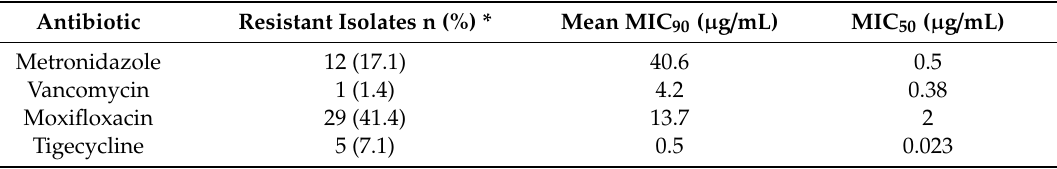
Table 2. Prevalence of all C. di ffi cile isolates resistant to various antimicrobial agents.